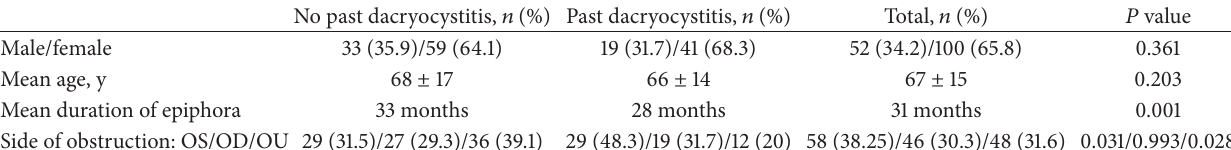
Table 1: Patients’ demographics and